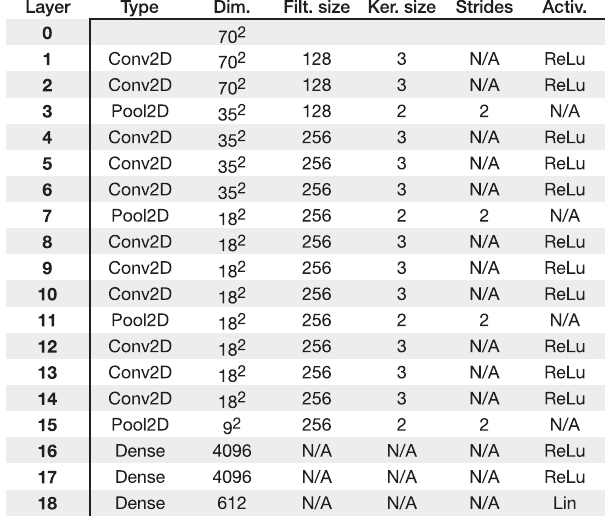
FIG. 13. Sketch of the NN layout for the two-component topological insulator case